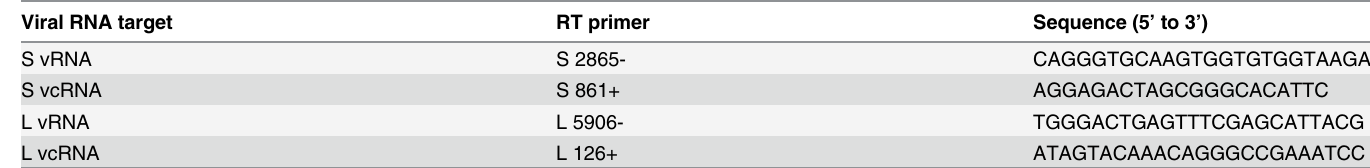
Table 1. RT primers. Viral RNA target